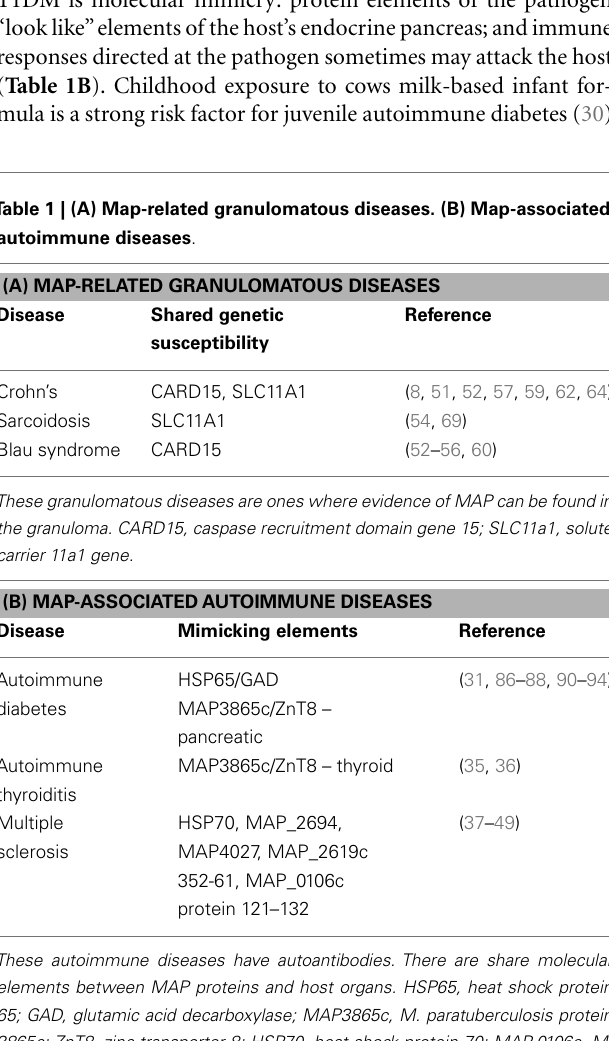
( Table 1B ). Childhood exposure to cows milk-based infant for- mula is a strong risk factor for juvenile autoimmune diabetes (30)